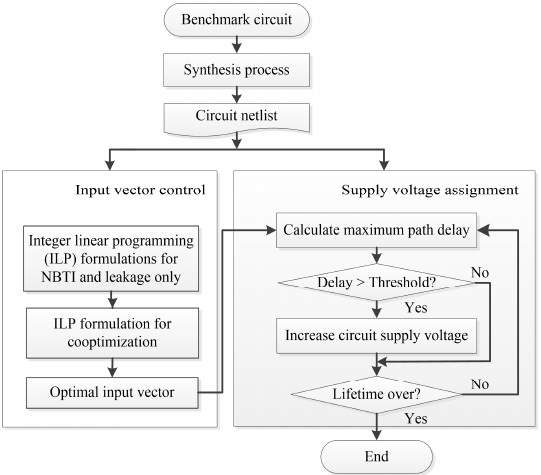
Figure 1. The flow of the proposed input vector control (IVC) and supply voltage assignment (SVA) combination method. NBTI, negative bias temperature instability.